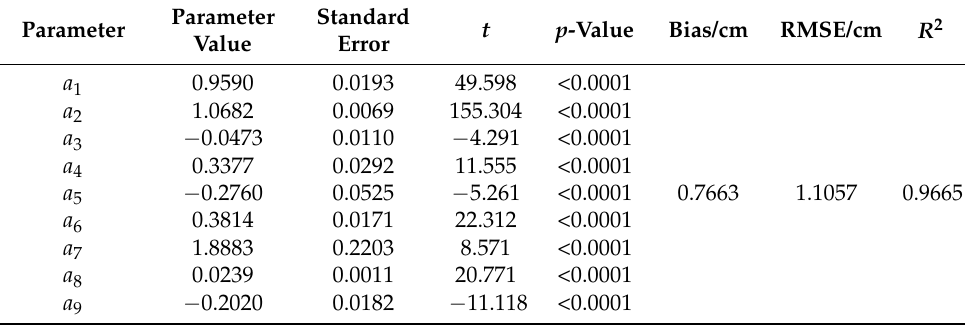
Table 7. Fitting parameters and statistics of the sample plot taper